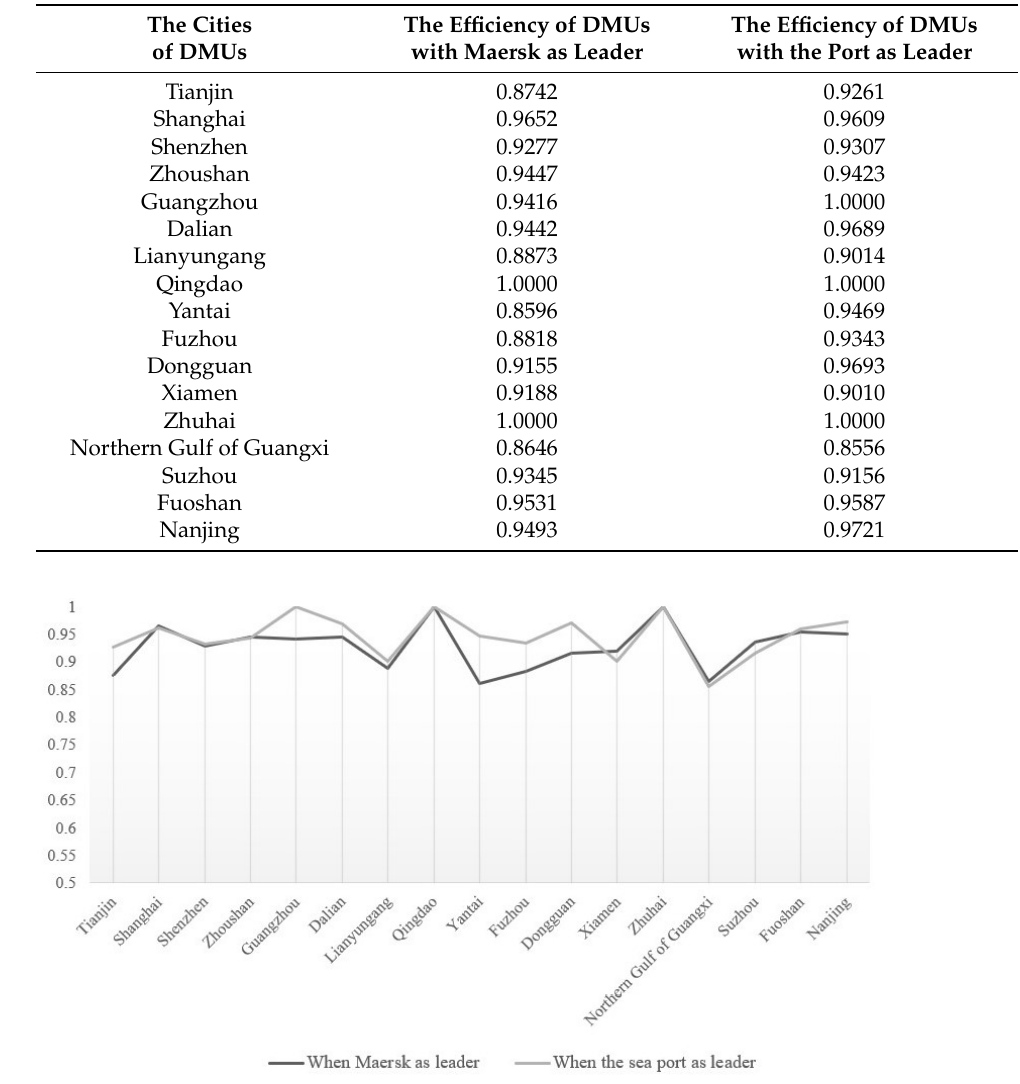
Figure 3. The sustainable efficiency of the marine supply chain under different